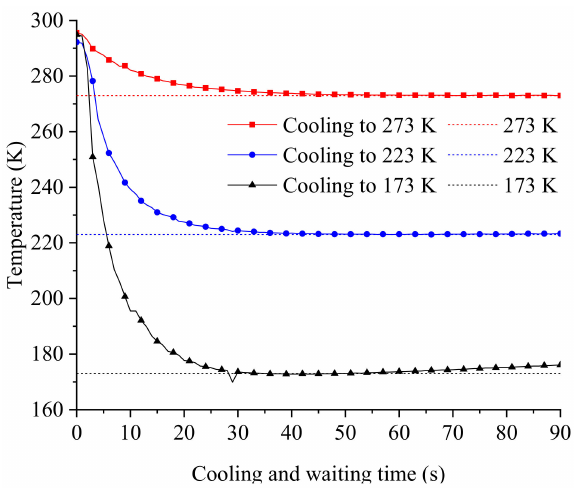
Figure 4. Evolution of the temperature inside a specimen placed between the cold